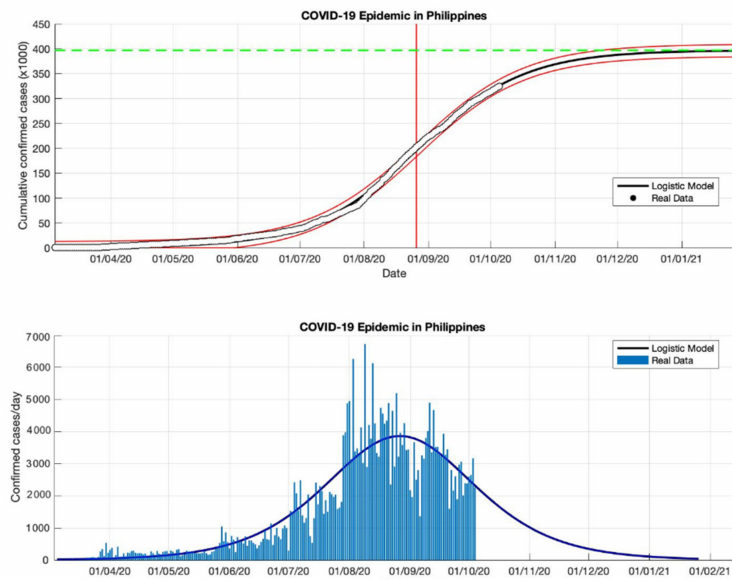
Figure 14. In the above figure, the prediction results of the logistic growth model for cumulative infected cases are compared with the actual data, while the two red lines between the black lines represent a prediction error limit of about 5%. The dashed green line predicts the total size of infected cases in the final phase of the epidemic. The red line intersects the cumulative case curve to predict the turning point or peak point of the epidemic (this line is parallel to the top of the curve from the below figure). In the below figure, the prediction results of this model for daily infected cases in the